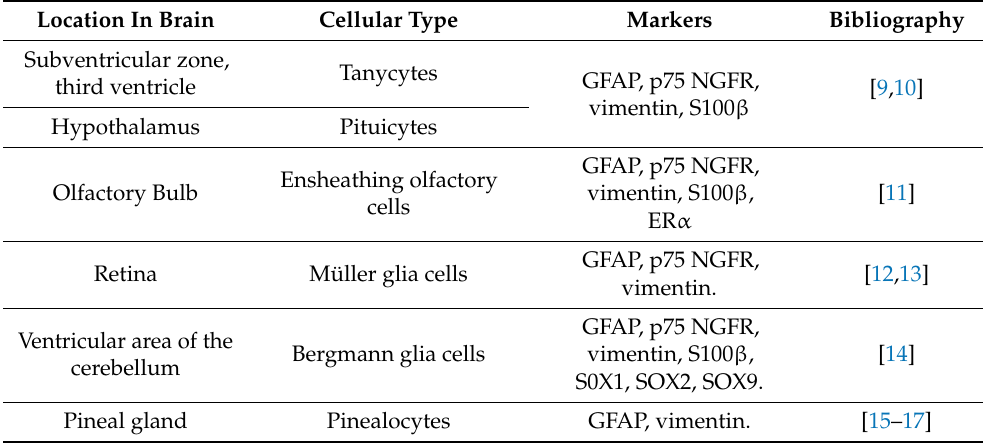
Table 1. Location in the brain and identity markers of aldynoglia